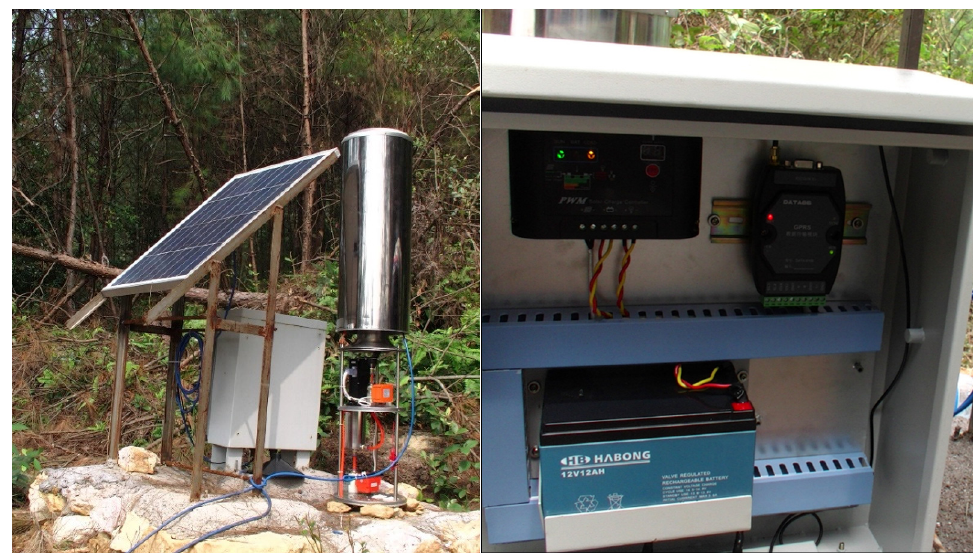
Figure 5. Automatic data collection and monitoring system.